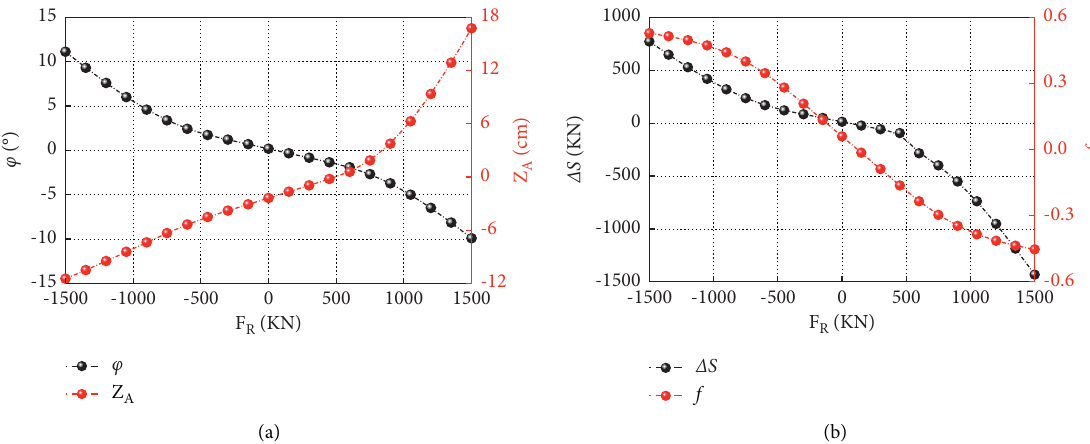
Figure 12: Influence of tangential load of roof on support stability ( h � 4m). (a) Influence of tangential load on support rotation. (b) Influence of tangential load on support